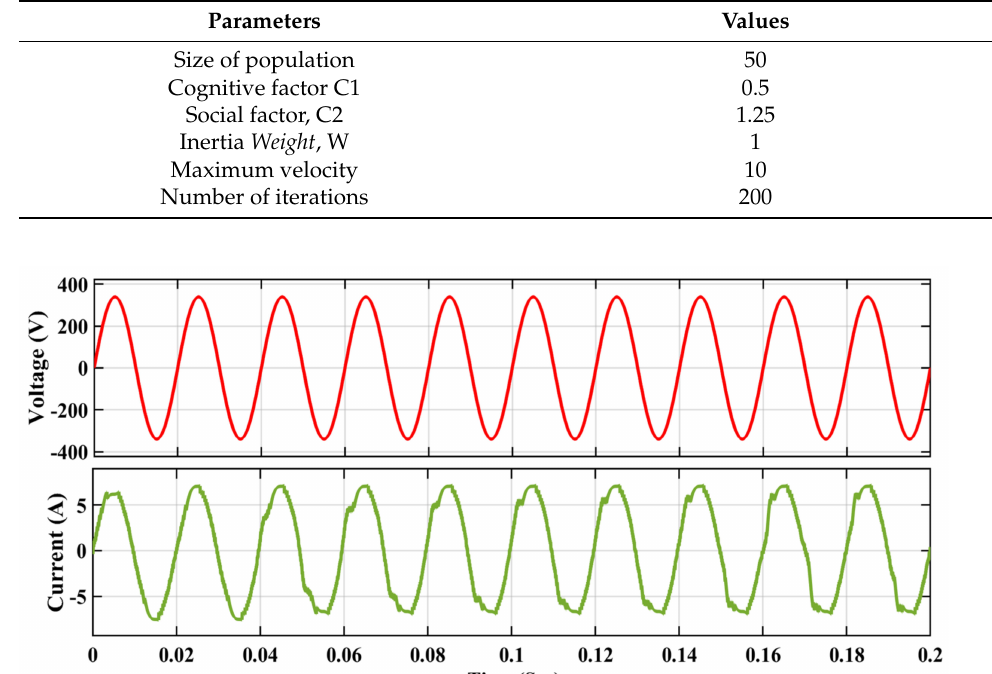
Table 3. Parameters & specifications of PSO.